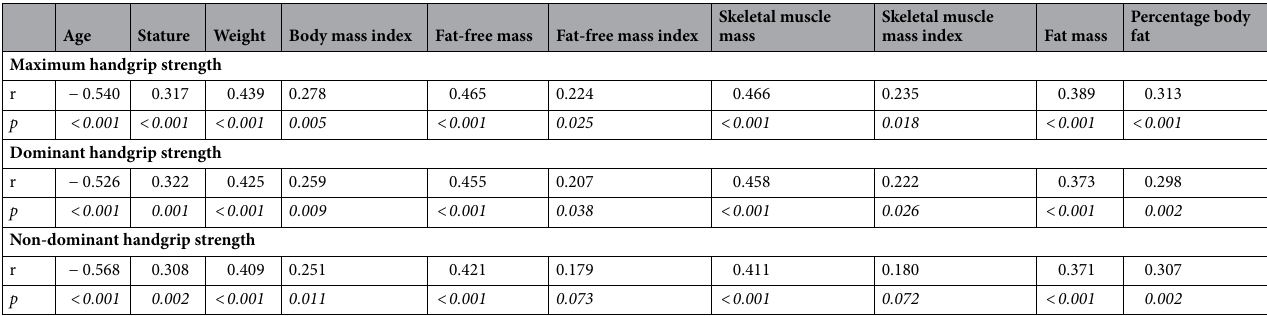
Table 4. Partial correlation (adjusted for gender) of handgrip strength with general anthropometric variables and body composition in the 102 patients with idiopathic pulmonary fibrosis (IPF) participating in the study. Italics values indicate statistically signidficant